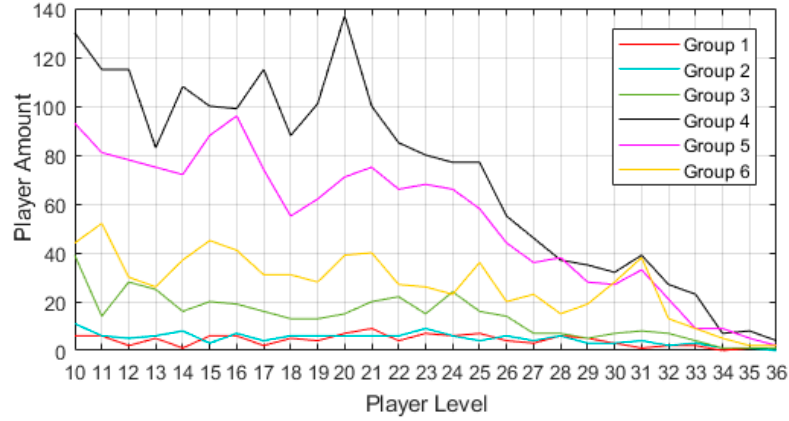
Figure 4. How players in the different groups are distributed, with the level.